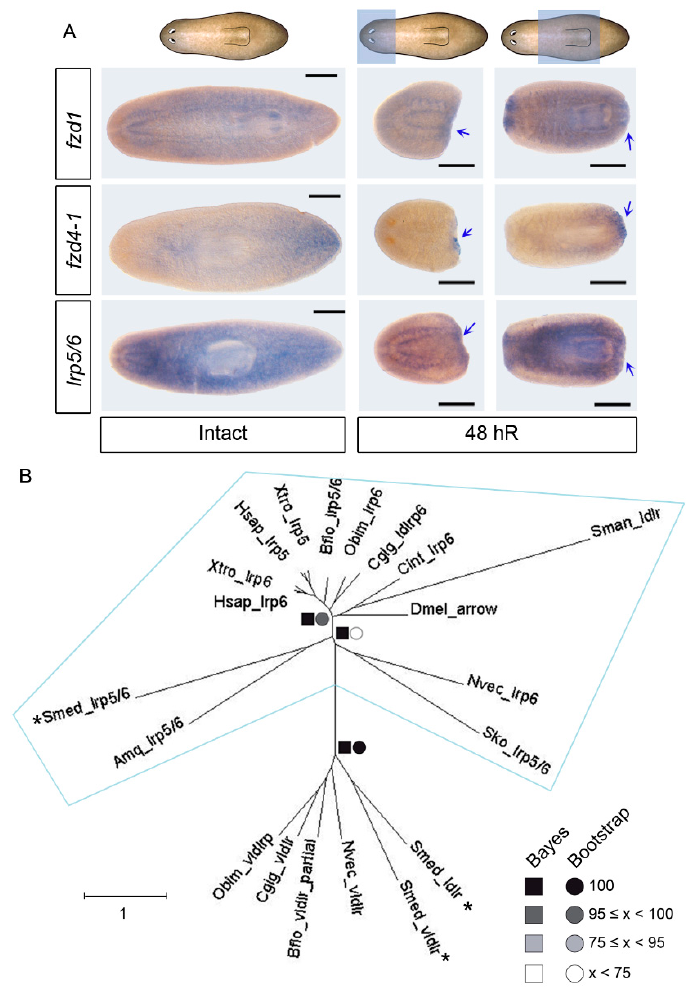
Figure 1. fzd1 , fzd4-1, and lrp5/6 are expressed in posteriors blastemas after amputation. ( A ) Whole-mount in situ hybridization (WISH) of fz1 , fzd4-1, and lrp5/6 in intact animals and at 48 h of regeneration (48 hR), showing its presence in posterior blastemas (blue arrows). Blue shadows in the schematic cartoons represent the studied regenerative pieces: heads and trunks. Scale bar: 100 µm. ( B ) The phylogenetic tree based on LRP sequences (Table S1) showed that lrp5, lrp6, and lrp5/6 genes cluster together. At nodes, values for the approximate Bayes (square) and Likelihood (circle) ratio tests are shown. Colour indicates % of confidence. Dark asterisks indicate Schmidtea mediterranea ( Smed ) genes. Scale indicates expected aminoacidic substitution per site. The following species were used: Homo sapiens ( Hsap ), Xenopus tropicals ( Xtro ), Branchiostoma floridae ( Bflo ), Saccoglossus kowalewski (Sko ), Crassostrea gigas ( Cgig ), Octopus bimaculoides ( Obim ), Schistosoma mansoni ( Sman ), Nematostella vectensis ( Nvec ), and Amphimedon queenslandica ( Amq ).